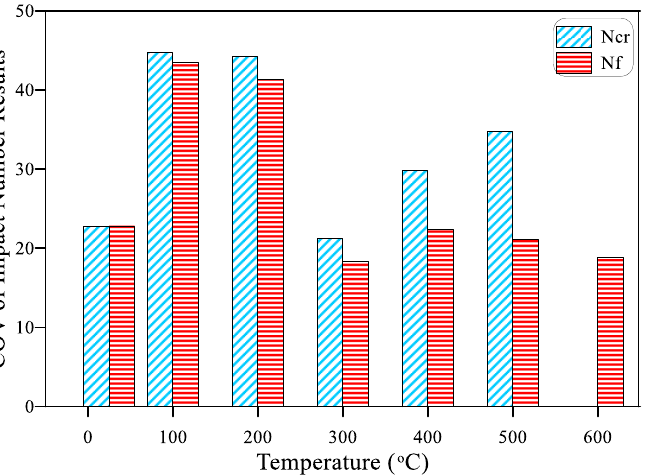
Figure 13. Coefficient of variation of the cracking and failure impact numbers at different tempera- tures.